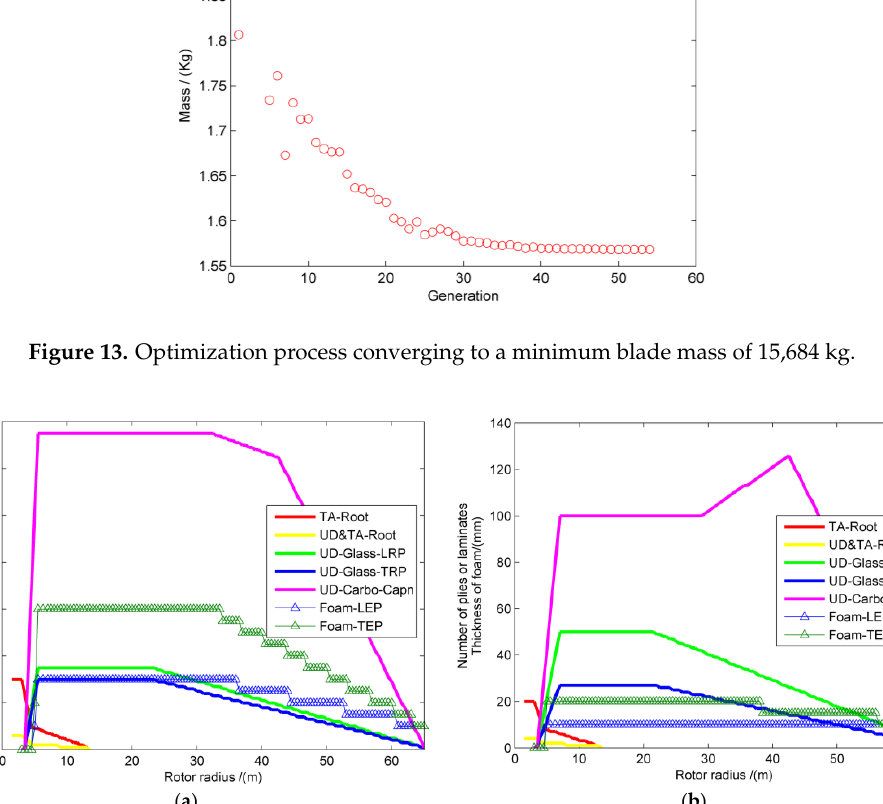
Figure 14. Comparison of the material layups between the ( a ) initial; and ( b ) optimized blades.